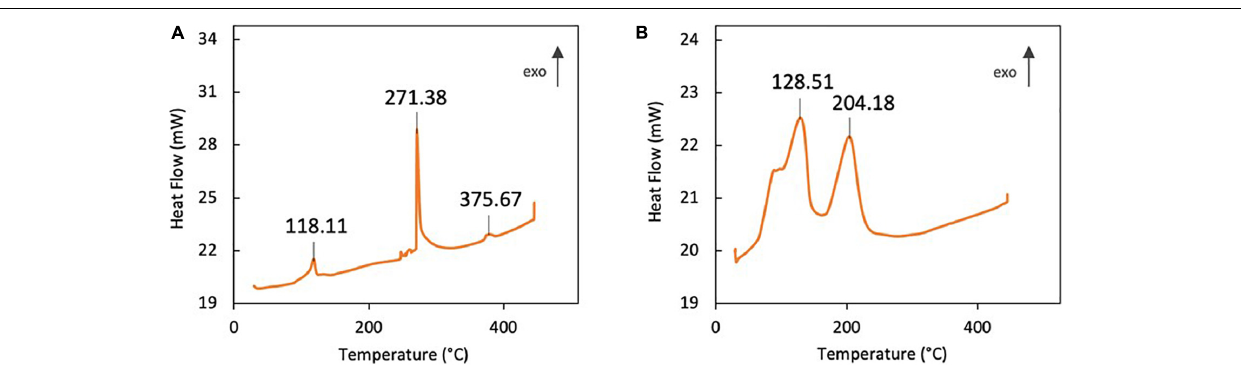
FIGURE 3 | TGA of (A) VOP1 and (B) VOP2.